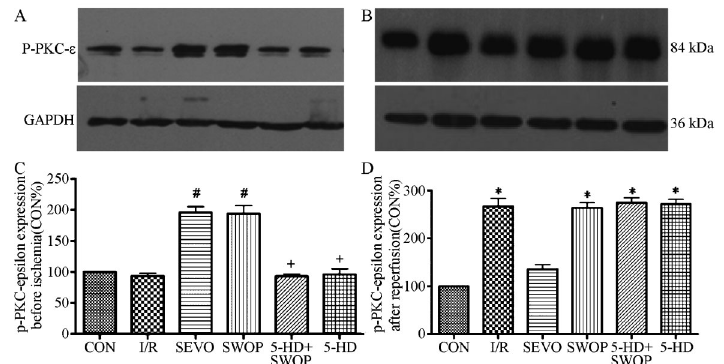
Figure 3. p-PKC- e expression before ischemia ( A , C ) and 2 h after reperfusion ( B , D ). p-PKC- e : phosphorylated protein kinase C- e ; CON: con- trol; I/R: ischemia/reperfusion; SEVO: sevoflur- ane; SWOP: second window of protection; 5-HD: 5-hydroxydecanoate. *P , 0.05 vs CON;